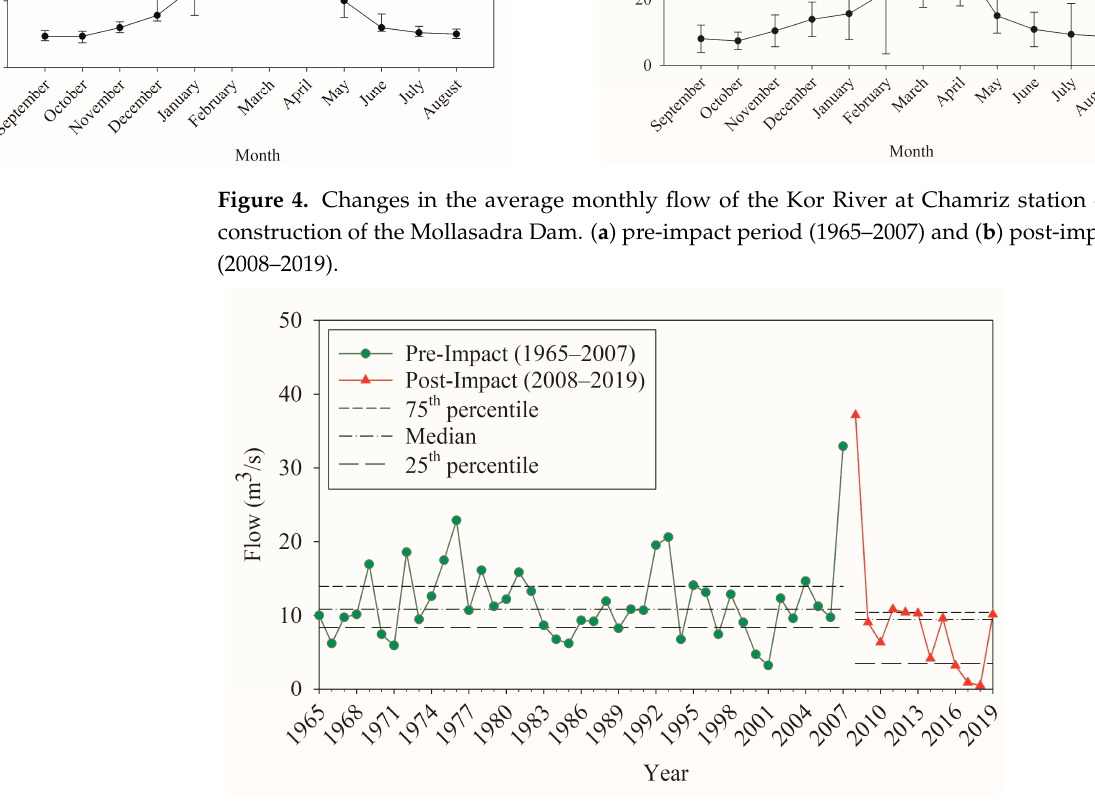
Figure 5. Variation of the Kor River flow in July before and after the construction of Mollasadra Dam. Table 10. Monthly flows of the Kor River using the Range of Variability Approach (RVA) method (m 3 /s).